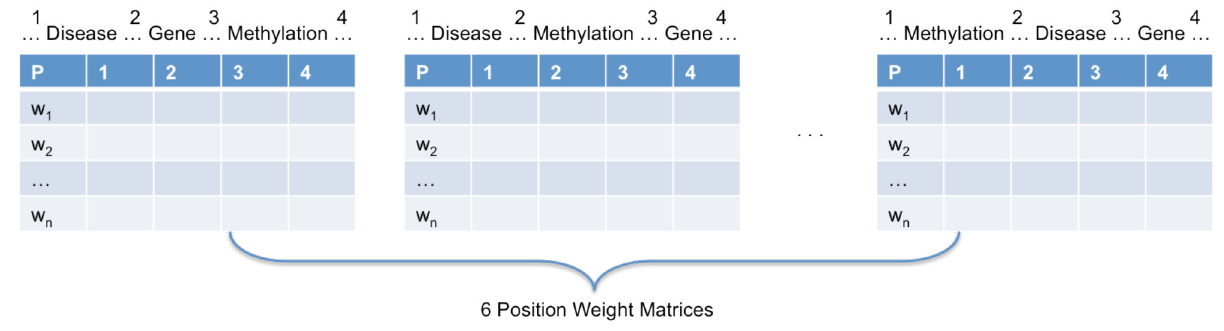
Figure 2. The structure of PWMs. We can generate six PWMs, and each matrix corresponds to a pattern order. For example, the first PWM to the left corresponds to the pattern order (<Disease>, <Gene>, <Methylation Word>). Each row corresponds to a word, and each column corresponds to a segment, and cells of the matrix represent the frequency of words in each segment. doi: